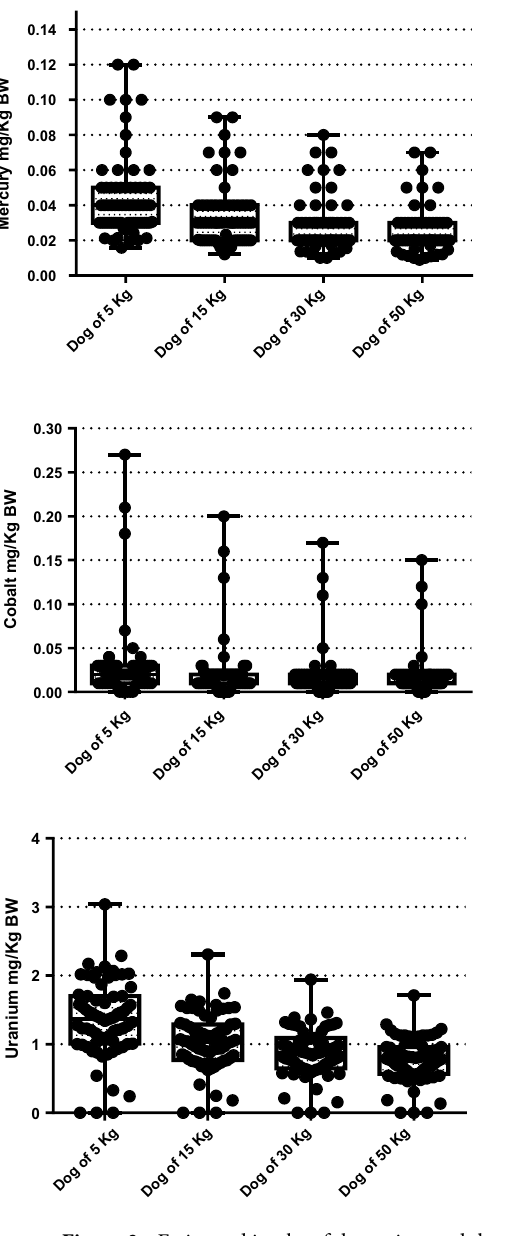
Figure 3. Estimated intake of the toxic metal that exceeded the maximum tolerated level (MTL) per kg of body weight (BW) of dogs of different